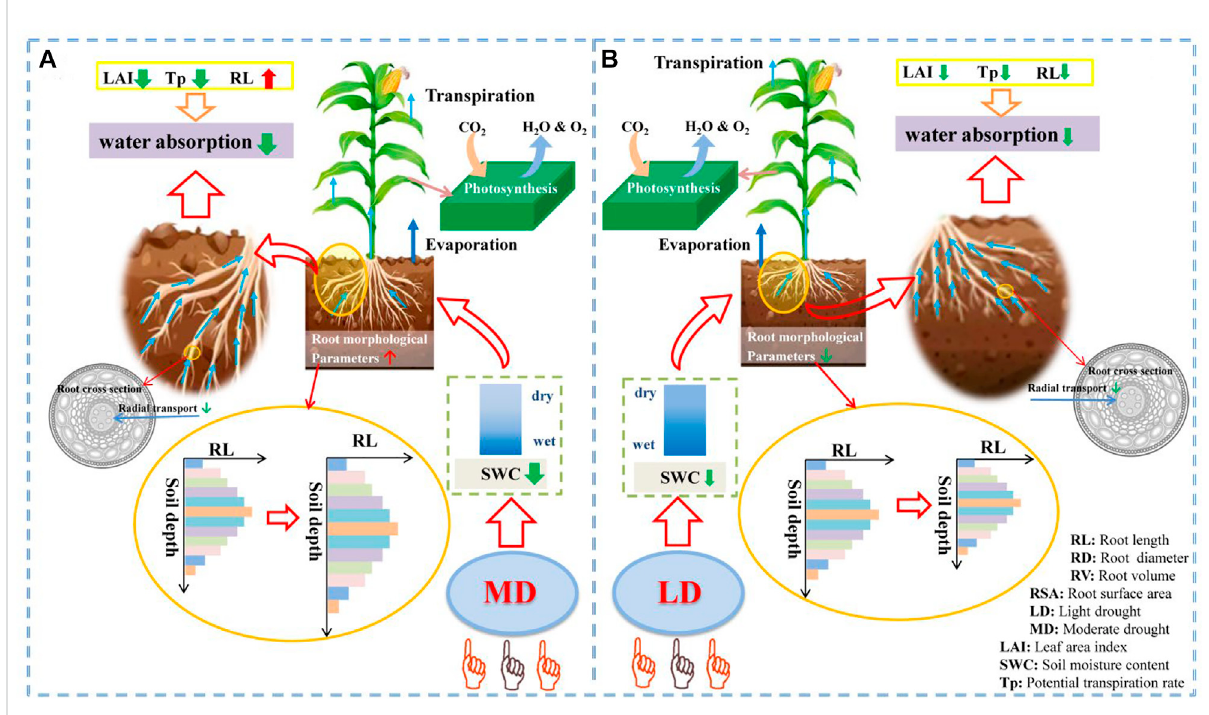
FIGURE 10 Explanationofadaptivemechanism processofsummermaizeunderdroughtstress. (A)(B) istheprocesschartofrootmorphologychangeand root water absorption change under the MD and LD. The red up arrow indicates the positive impact, the green down arrow indicates the negative impact, and the width of the arrow indicates the